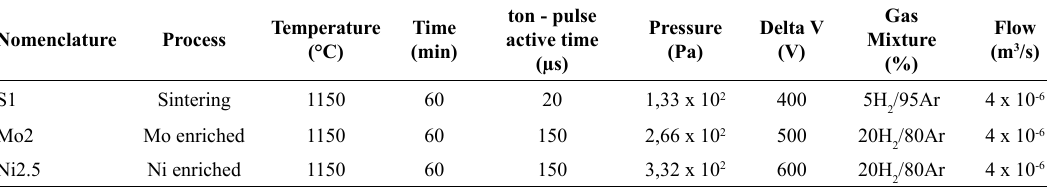
Table 1. Parameters of plasma